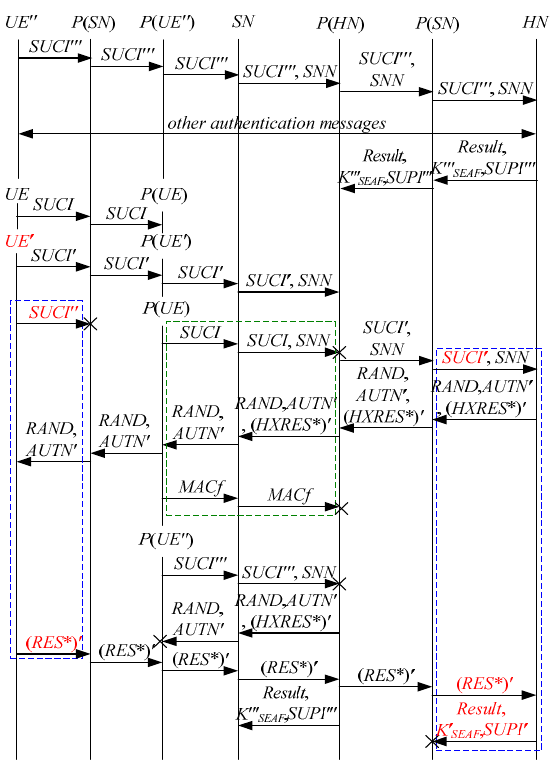
Figure 20. The nineteenth attack scenario of the 5G AKA protocol.